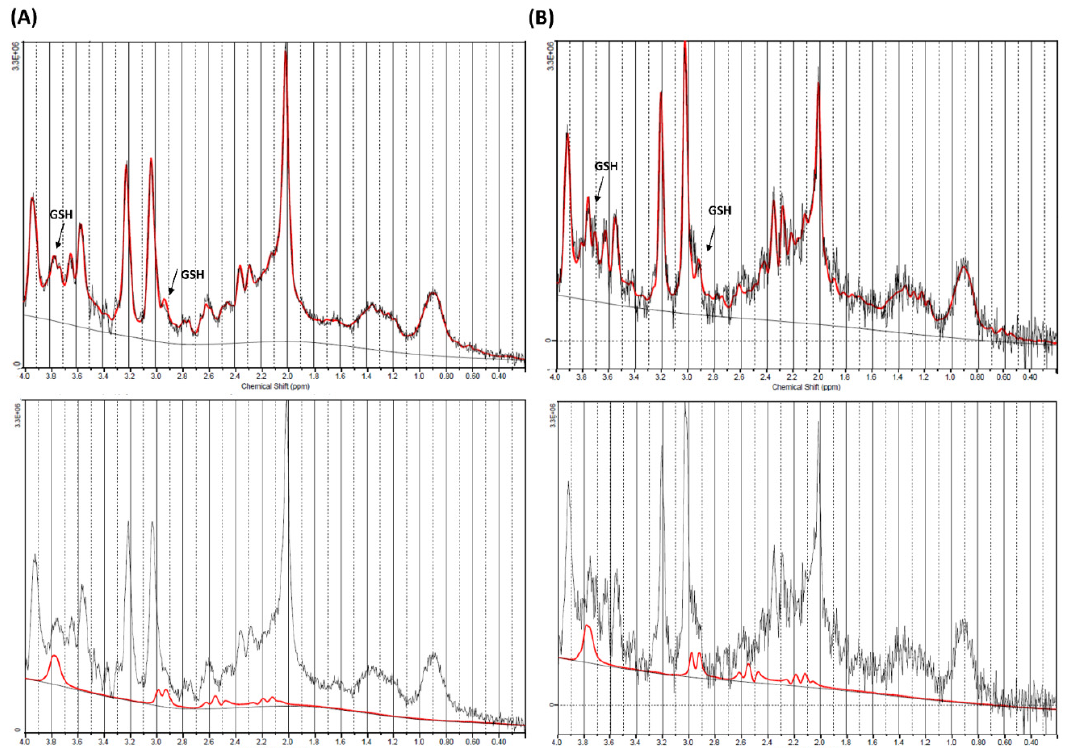
Figure 2. Magnetic resonance (MR)-spectrum obtained within ganglio-capsular volume of interest (VOI) for a control ( A ) and a Ketogenic Diet (KD) patient ( B ). Composite spectrum (above) presents glutathione (GSH) peaks of approximately 2.95 and and 3.75 ppm (black arrow), that are more visible on the GSH fitting spectra (below).